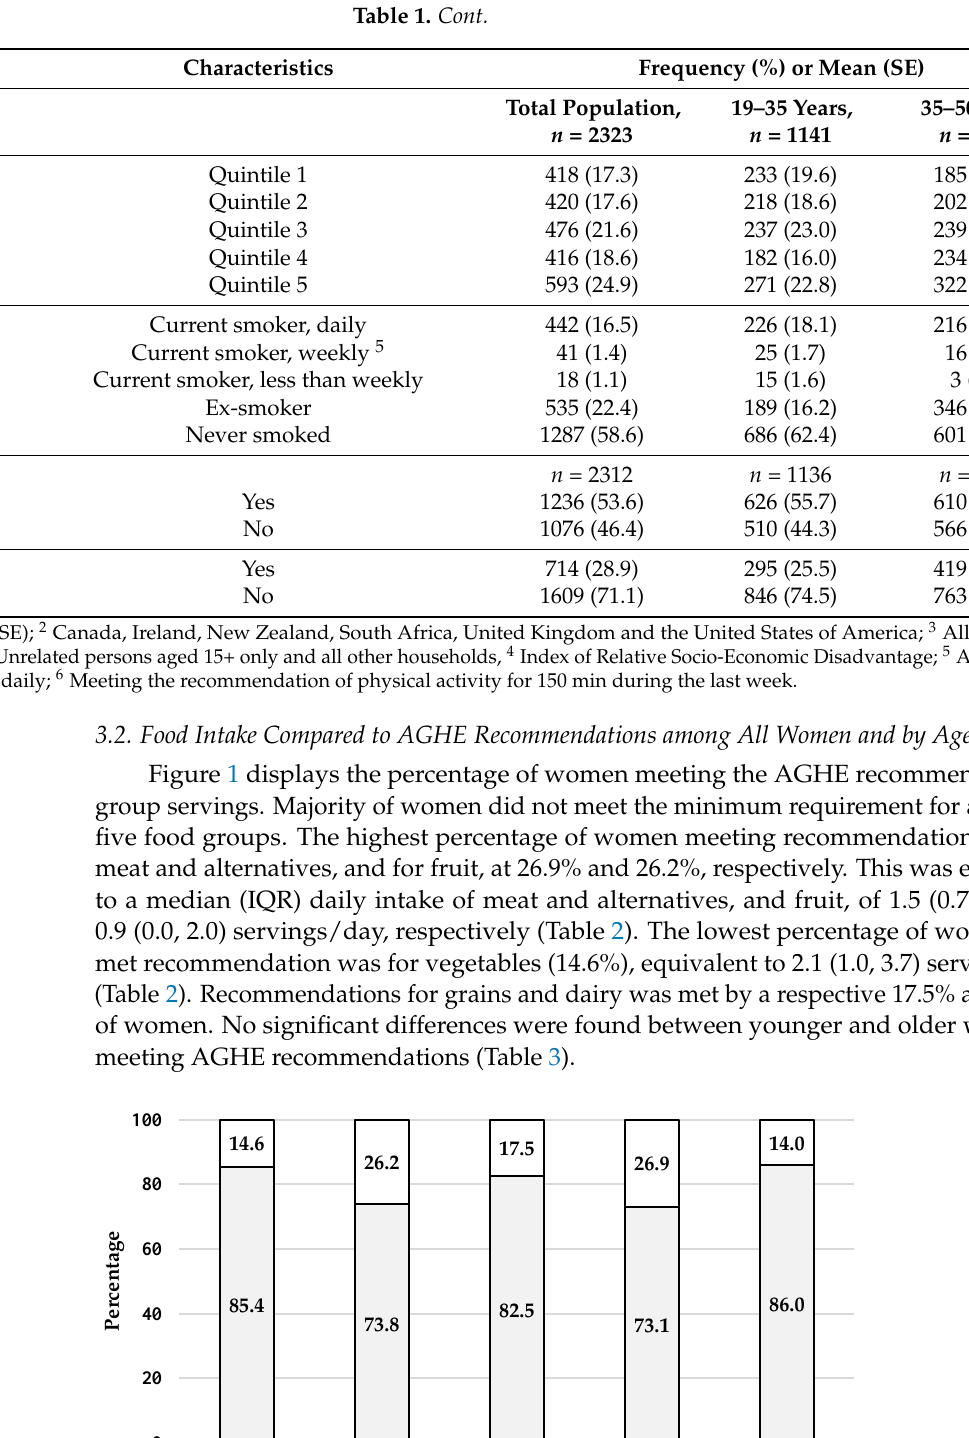
Table 2. Food group intakes for the whole population and by age group. Daily Servings, Median (IQR)